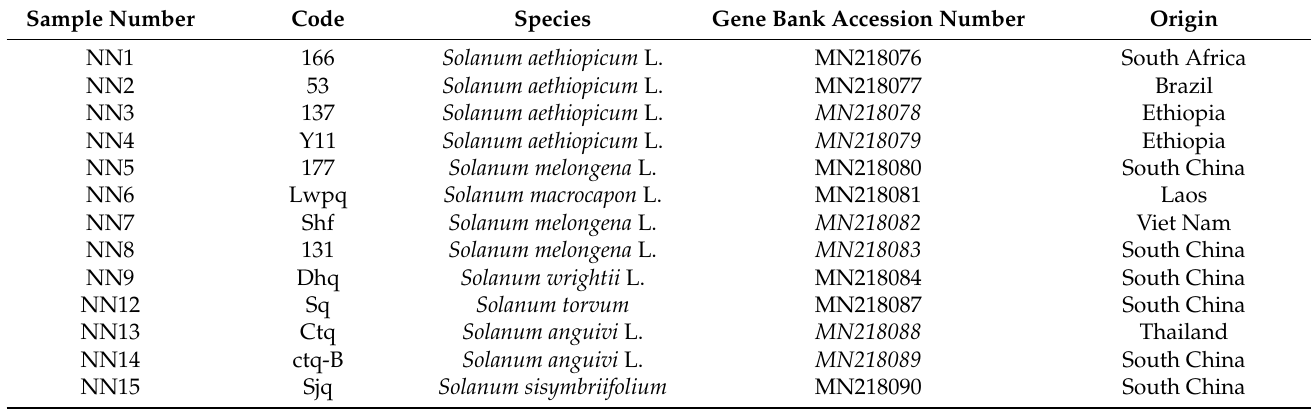
Table 1. List of test